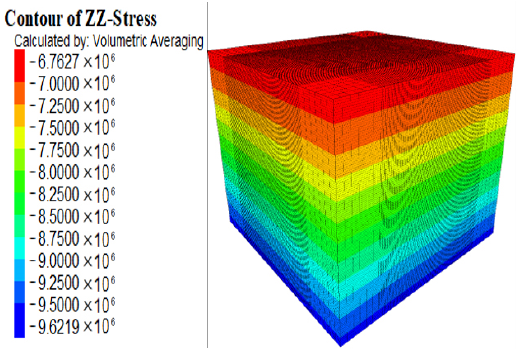
Figure 8. Initial equilibrium diagram of